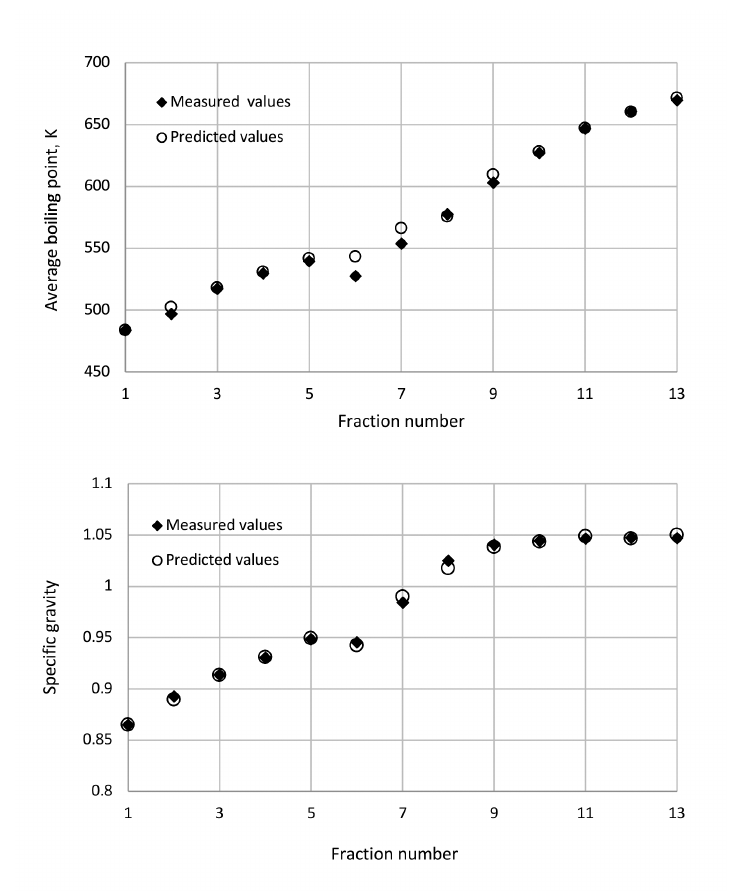
Fig. 2. Comparison of the performance of the average boiling point model and the specific gravity model for fractions from a typical distillation. For the average boiling point, the experimental error bars are data point sizes. For the specific gravity, experimental error bars are smaller than the data